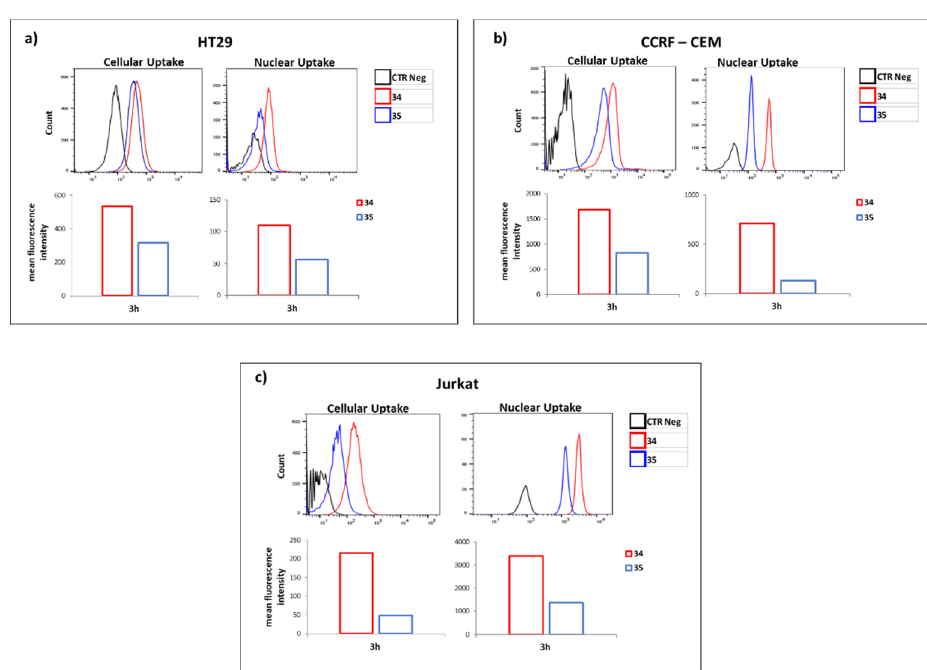
Figure 6. Mean fluorescence intensity of the HT29 ( a ), CCRF-CEM ( b ) and Jurkat ( c ) cells containing 34 and 35 by FACS analysis (lower panel) and the representative results of FACS analysis (upper panel). CTR Neg was the fluorescence of untreated